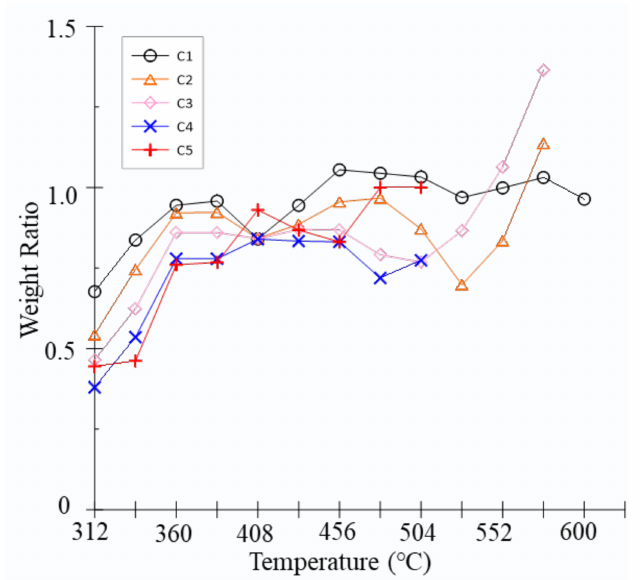
Figure 8. Yield ratio of individual gaseous hydrocarbons of core plugs to powdered